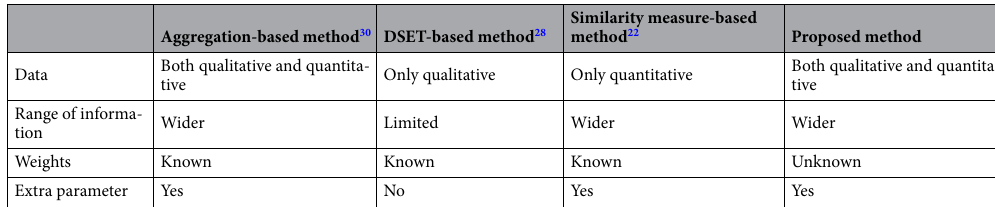
Table 15. Characteristic comparison of different